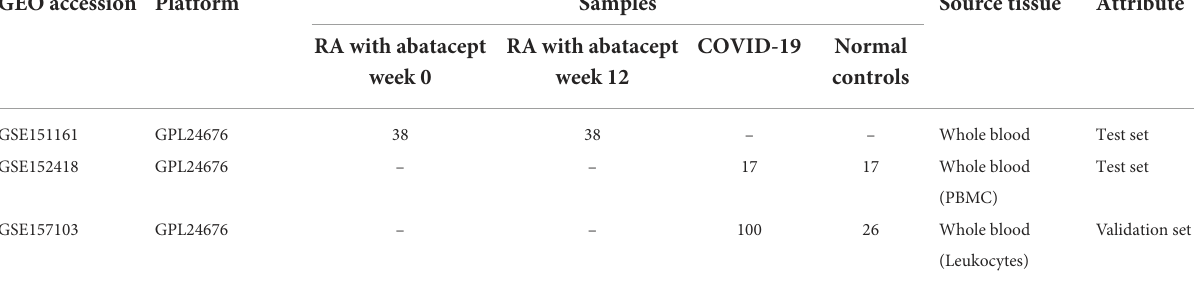
TABLE 1 Information for selected microarray